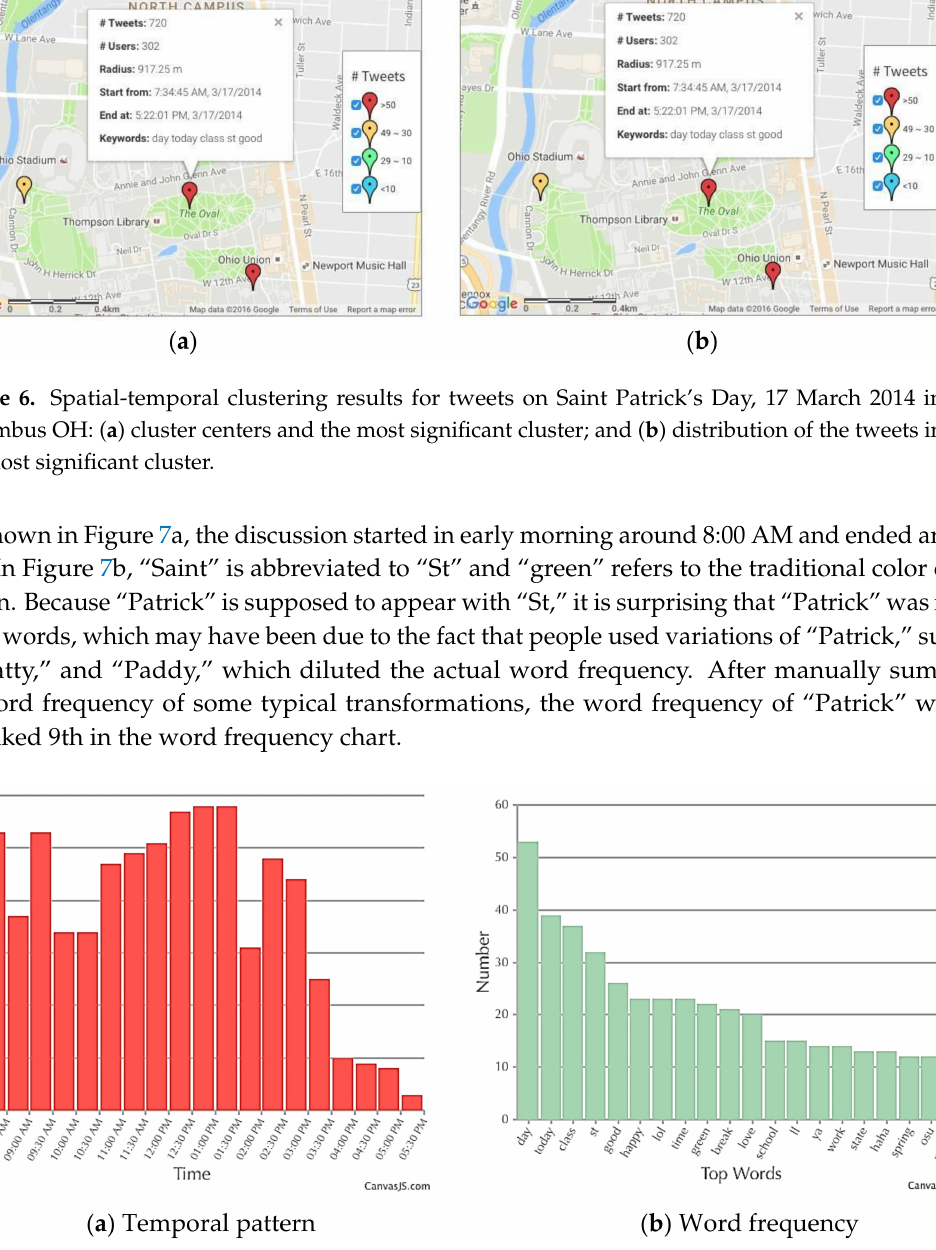
Figure 7. Temporal pattern and word frequency of Saint Patrick’s Day: ( a ) Temporal pattern; and ( b ) Word